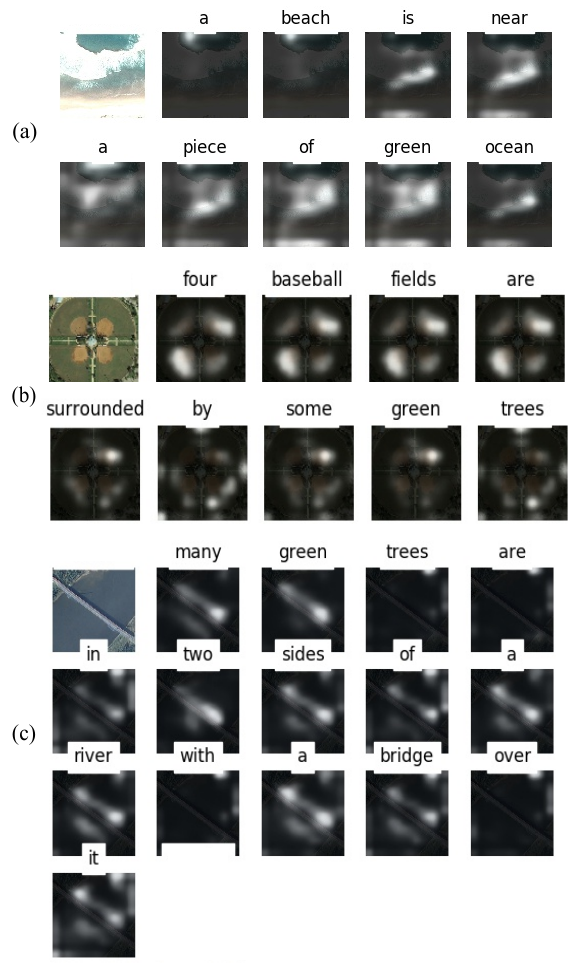
Figure 6. ( a – c ) Visualization of the stair attention